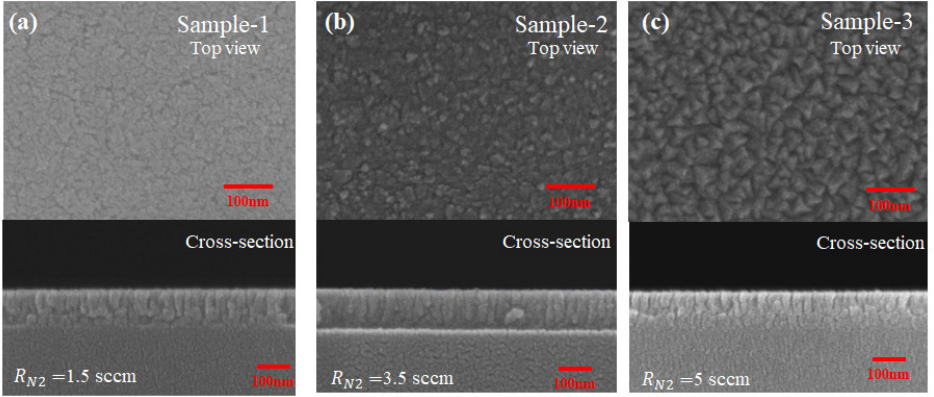
Figure 2. Cross-section and top-view scanning electron microscopic (SEM) images of titanium nitride (TiN) thin films.